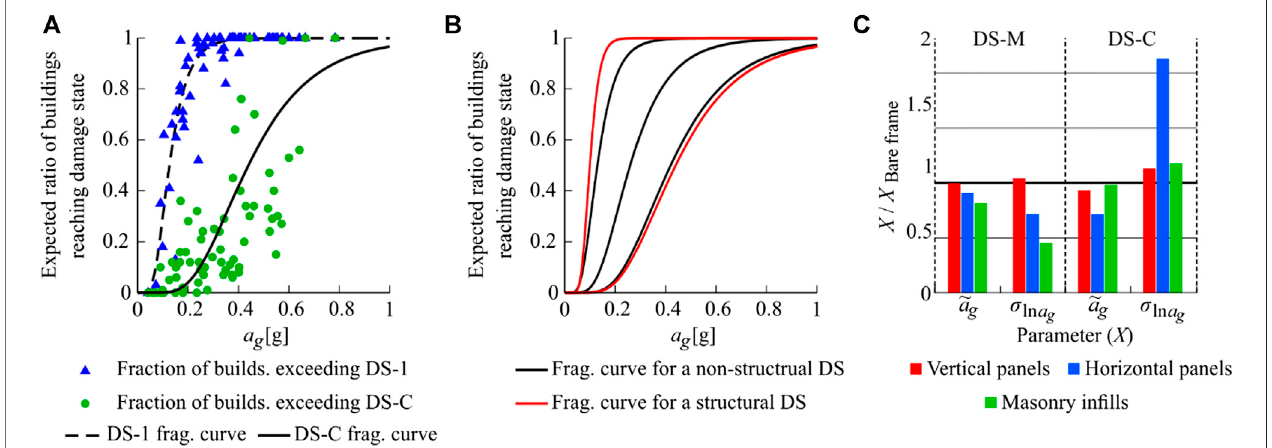
FIGURE11|(A) RatiosofbuildingsfrombuildingclassHexceedingDS-1andDS-Cwiththecorrespondingfragilitycurves, (B) allfragilitycurvesofbuildingclassV, and (C) fragility parameters (median and logarithmic standard deviation) of buildings classes V, H and M normalized to the fragility parameters of building class B.